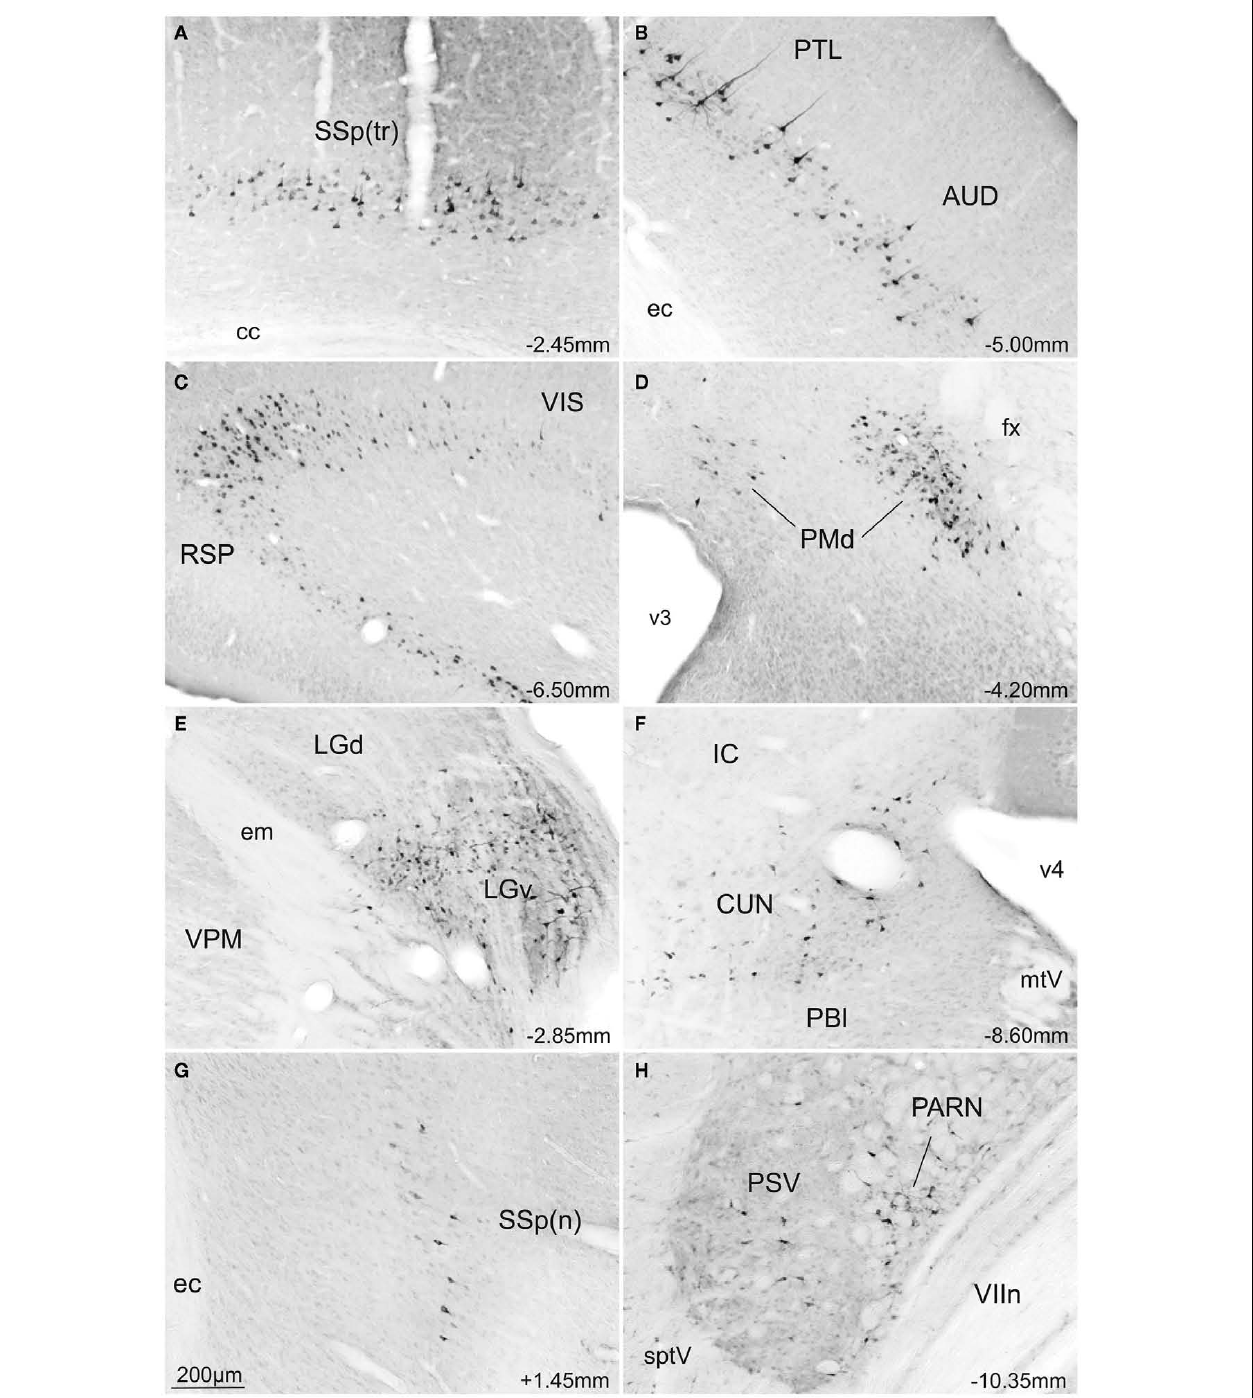
FIGURE 6 | Photomicrographs of transverse sections of the rat brain showing some of the areas with exclusive FG-stained cells from a rat injected into the SCm (A–F) or into the SCl (G,H). Abbreviations: see list.